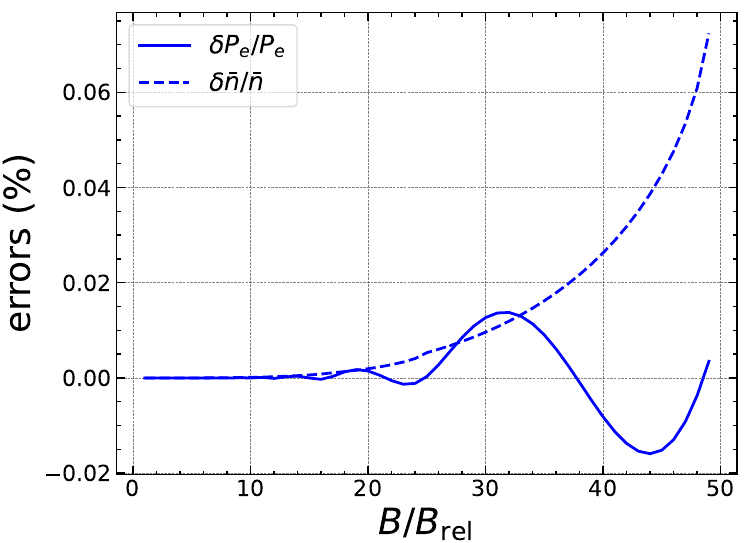
Figure 1. Relative errors (in %) of the approximate analytical expansions (14) and (16) for the baryon number density ¯ n (dashed line) and electron pressure P e (solid line), respectively, as a function of the magnetic field strength B (cid:63) = B / B rel with γ e = 10. The errors are obtained by taking the difference between the approximate and exact results and dividing by the exact result. All electrons are confined to the lowest Landau–Rabi level at B (cid:63) = ( γ 2 e − 1 ) /2 =